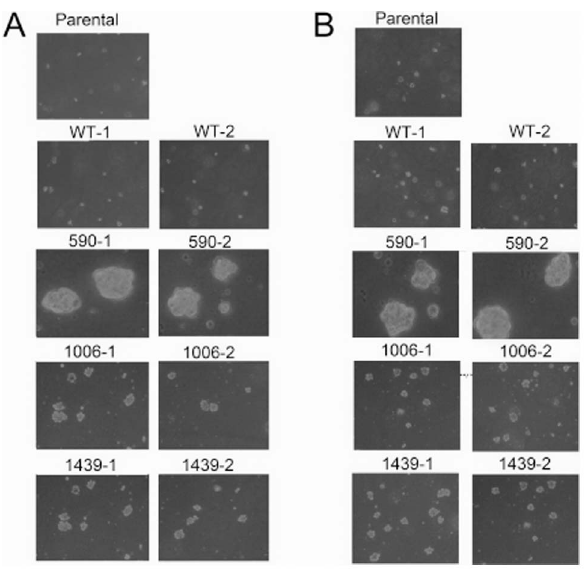
Figure 4. Soft agar colony formation of the cells expressing mutant SWAP-70 s. (A) 1 6 10 4 cells were plated into soft agar in 6- well plates. Cells were observed for 10 days. On the sixth day, agar overlay was performed. (B) Similar experiments were performed in the presence of 10 m M PD98059.